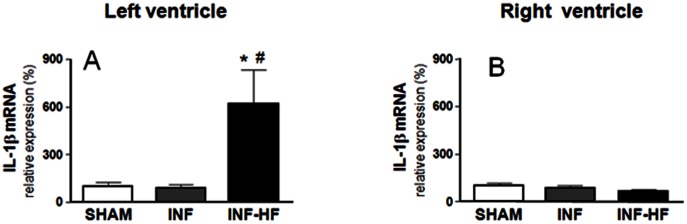
Interleukin-1β (IL-1β) mRNA levels in left (A) and right ventricle (B) of sham-operated rats (SHAM) and infarcted animals with (INF-HF) or without heart failure (INF) 30 days after ligation of left coronary artery.Results were normalized by 18S expression levels. Data are mean ± S.E.M. *p<0.05 vs. SHAM group; # p<0.05 vs INF group.